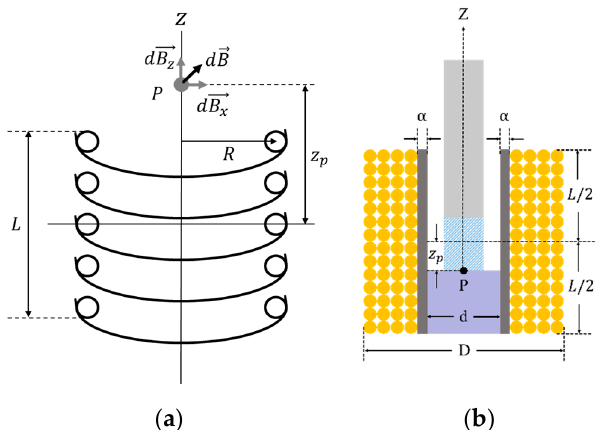
Figure 8. ( a ) The electromagnetic field diagram caused by circular coils ( 𝑃 is the point of interest for electromagnetic analysis; 𝐵 (cid:3053) (cid:4652)(cid:4652)(cid:4652)(cid:4652)⃗ , 𝐵 (cid:3051) (cid:4652)(cid:4652)(cid:4652)(cid:4652)⃗ and 𝐵(cid:4652)⃗ are the electromagnetic field in the z, x-direction and sum-direction of z and x as the solenoid axis, respectively; L is the length of solenoid; R is the radius of circular coil; 𝑧 (cid:3043) is the distance from the center of the solenoid to point); ( b ) the cross-sectional view for solenoid design ( 𝑑 and 𝐷 are the inner diameter and the outer diameter of solenoid, respectively; 𝛼 is the thickness of the solenoid wall).